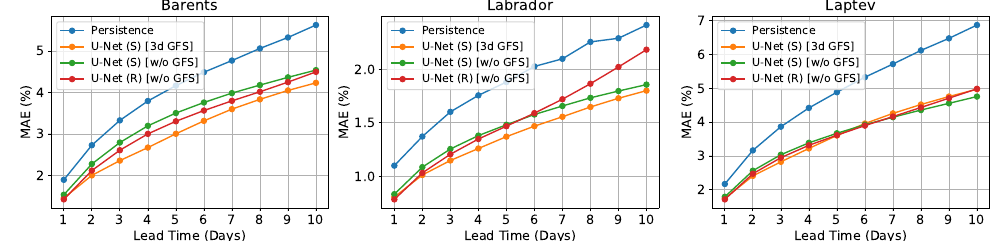
Figure 12. Dependence of JAXA SIC MAE (lower is better) on the number of forecast day in the future (lead time of the forecast) for all three regions. MAE is averaged over the whole year 2021. U-Net (S) and U-Net (R) are trained on all three regions merged and shuffled with 7 days history (past) and best inputs configuration, as presented in Table 3.